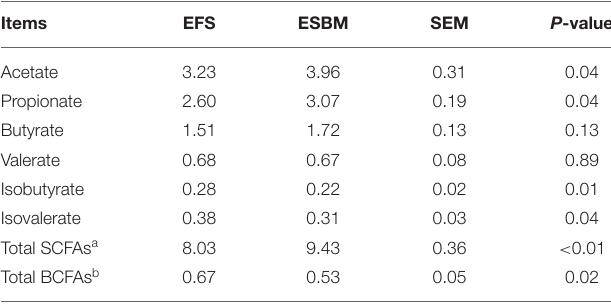
TABLE 5 | Effects of protein source on volatile fatty acid composition in cecal digesta of weaned pigs (mg/g